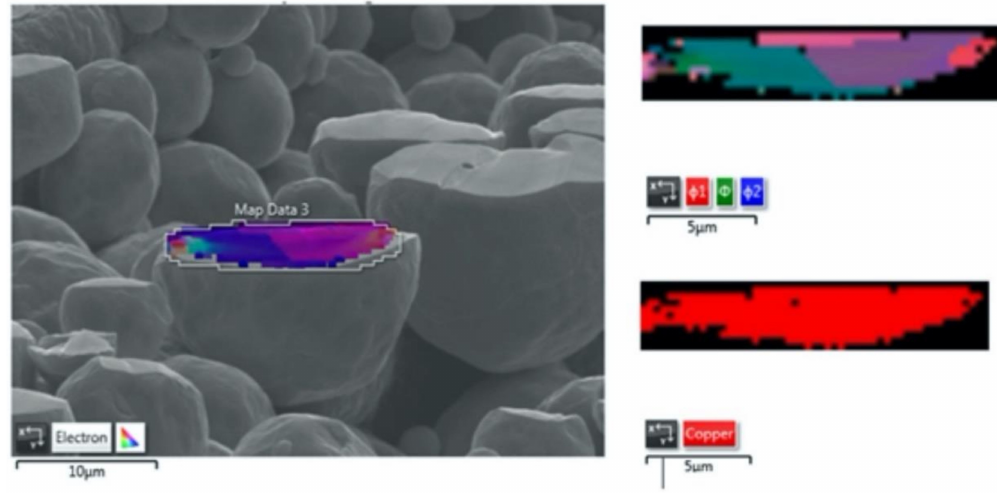
Figure 4. EBSD analysis of GA Cu powder.